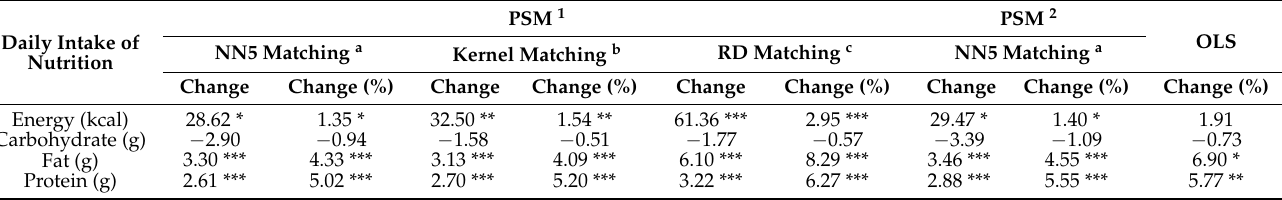
Table 2. Effects of internet access on food